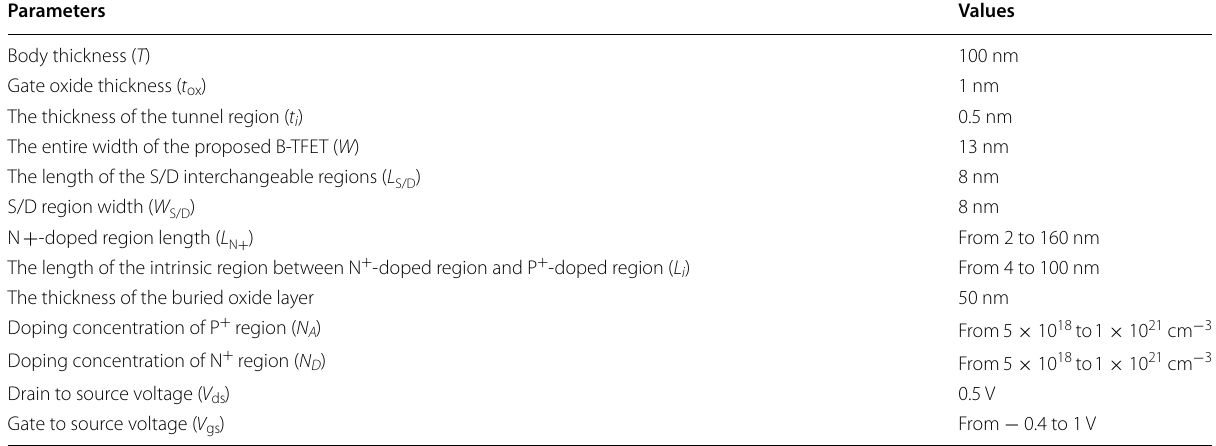
Table 1 Adopted device parameters